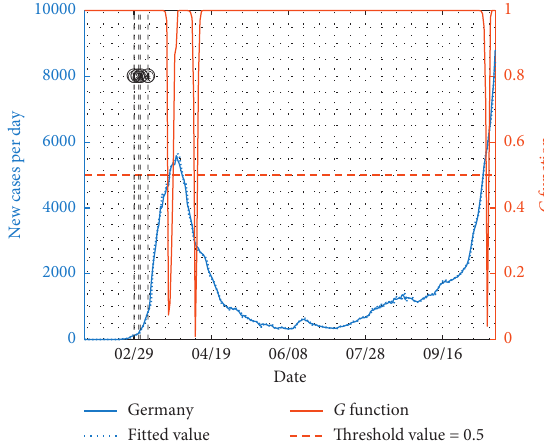
Figure 20: The fitting result of Germany containing the second wave. The left axis shows the daily confirmed cases for the real data after smoothness (blue solid line) and its fitted values by the STAR model (blue dashed line). The right axis shows the value of non- linear functions G changing with time (orange solid line) and the reference line with threshold 0.5 (orange dashed line). The vertical dotted line indicates the sequential released policies: ① close schools across the country, ② upgrade the risk level of the outbreak to “high,” and ③ tighten controls on social activities and